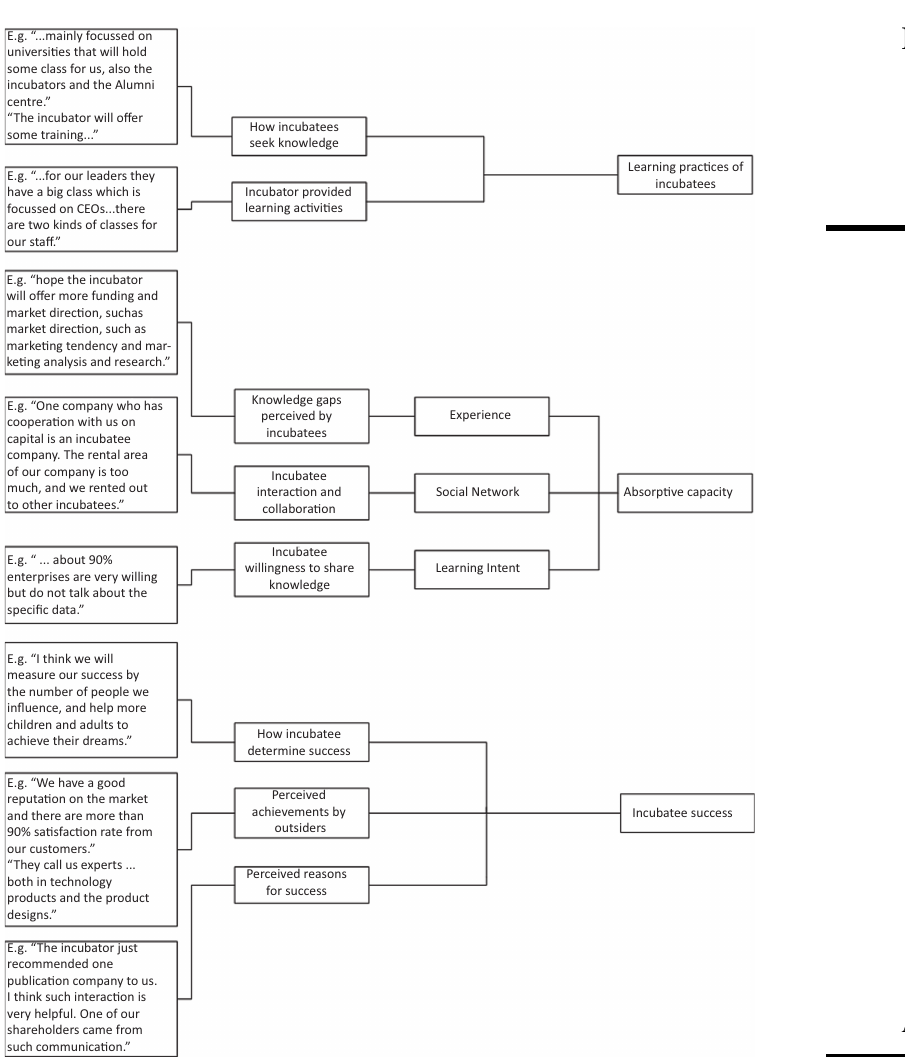
Figure 2. Analytic